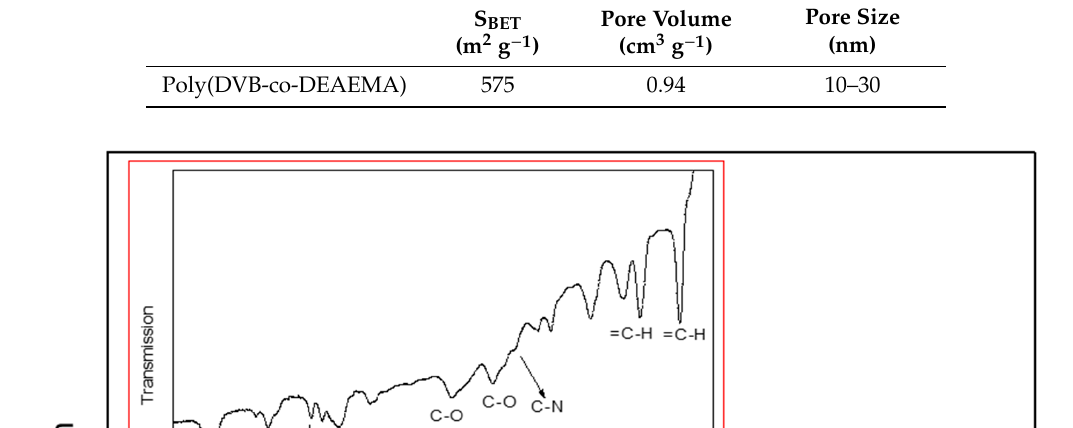
Table 1. Textural properties of the sorbent.